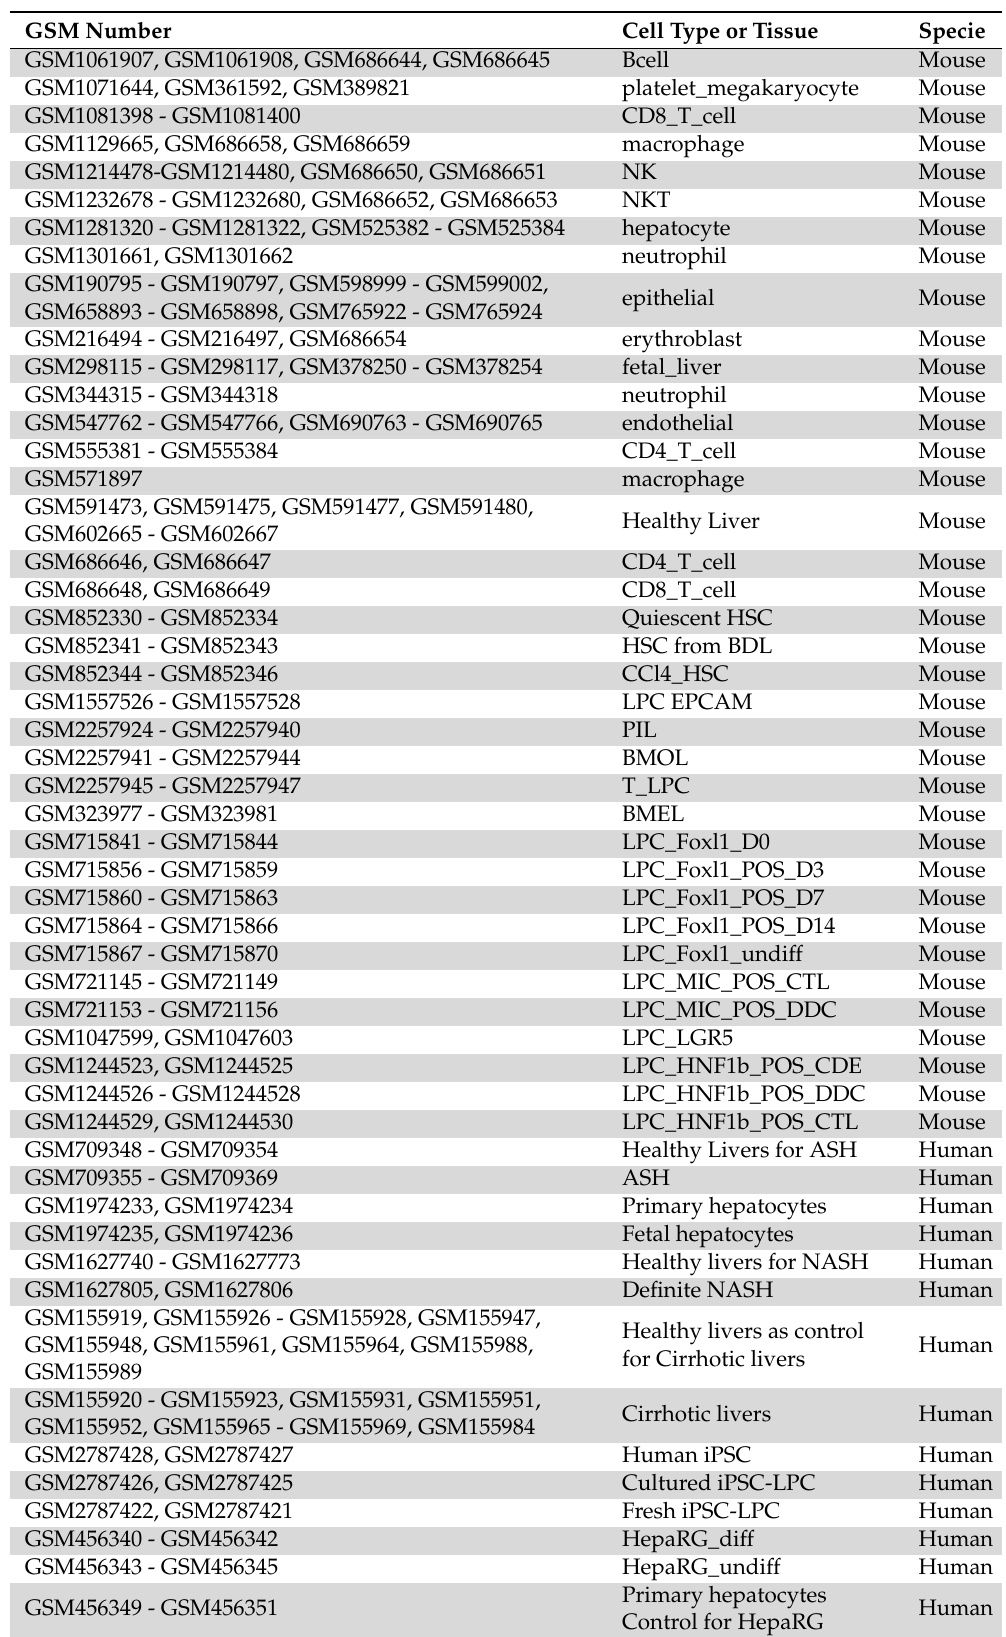
Table 2. Microarray GEO sample (GSM) number associated with cell type or